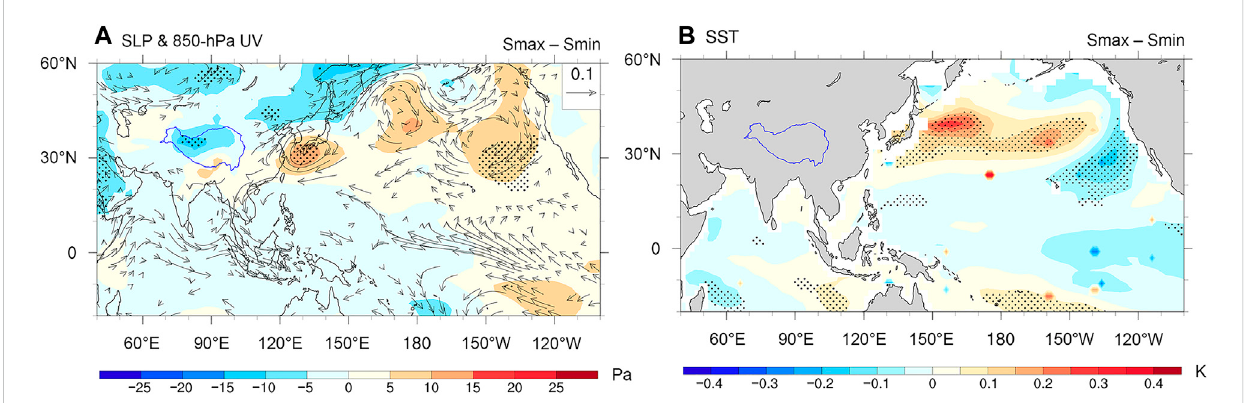
FIGURE 7 Compositedifferencesin (A) JJAmean850-hPawind(vectors,m s − 1 )andprecipitation(shading,mm day − 1 )and (B) seasurfacetemperature(SST,K) between the 11-year Smax and Smin phases from the ensemble-mean result of four TSI experiments in the CESM ‒ LME. The black dots denote signi fi cance at the 90% con fi dence level (two-tailed Student ’ s t -test).